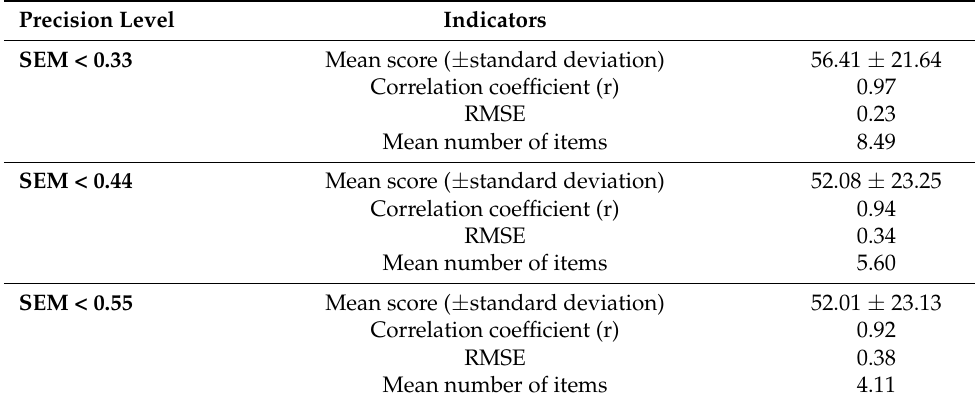
Table 4. Mean scores and precision indicators for each CAT